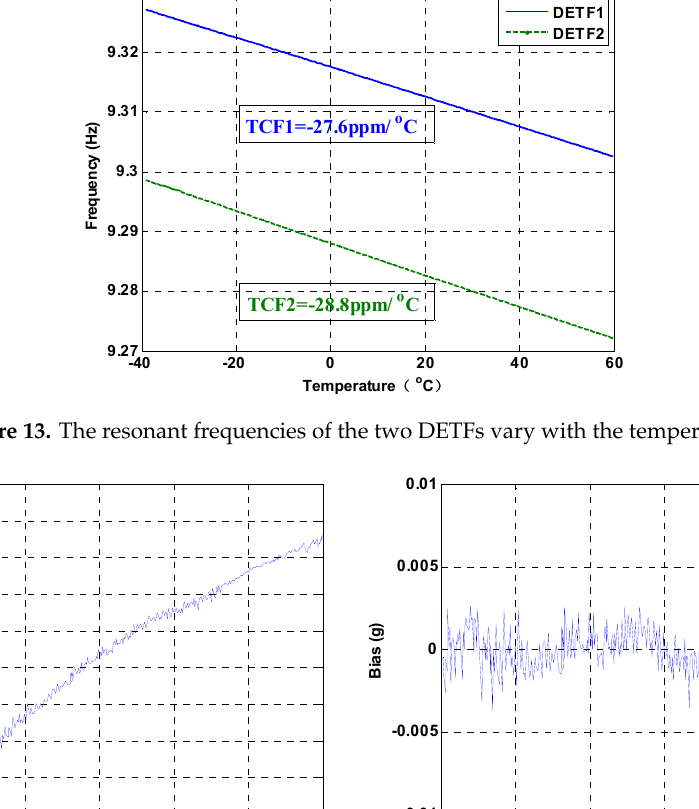
Figure 14. The bias of the SRA vary with the temperature. ( a ) Raw bias output. ( b ) Compensated bias output.